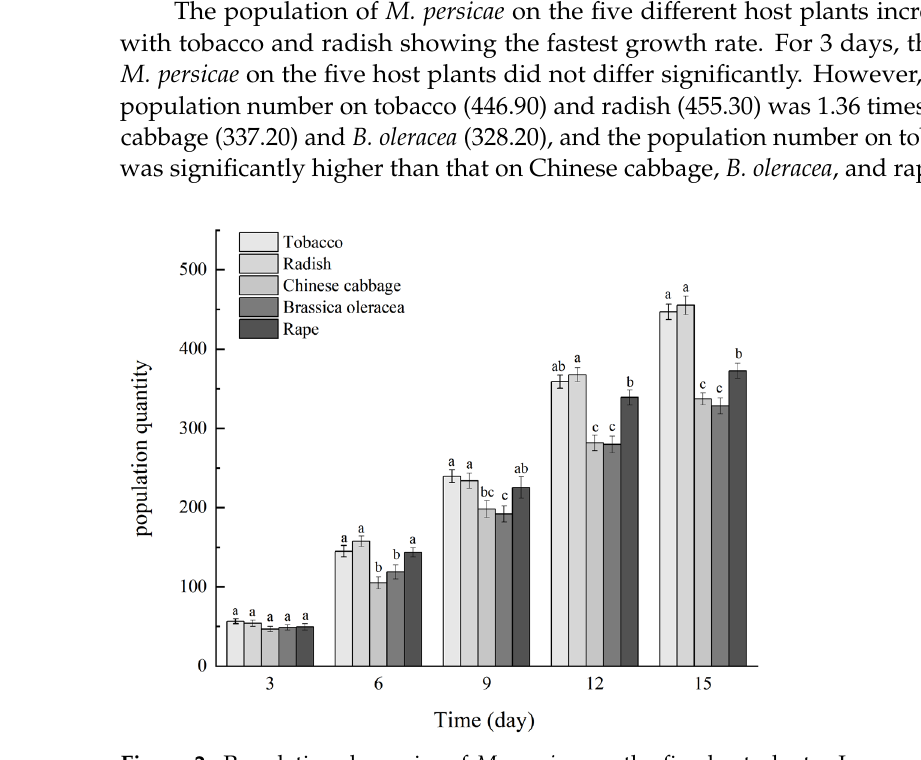
Figure 2. Population dynamics of M. persicae on the five host plants. Lowercase letters indicate significant differences ( p < 0.05) among the five host plants, which were assessed using one-way analysis of variance with Fisher’s least significant difference test at α = 0.05.